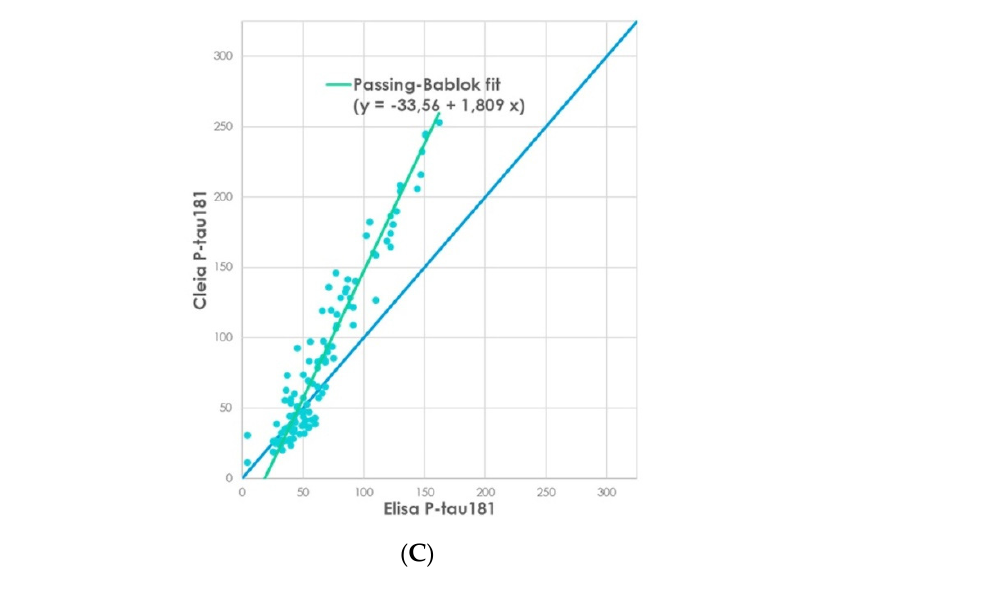
Figure 1. Correlation analysis by non-parametric Passing–Bablok regression for method comparison between classical manual ELISA and Lumipulse assay for all 111 subjects: ( A ) A β 42, ( B ) T-tau, ( C ) P-tau181.